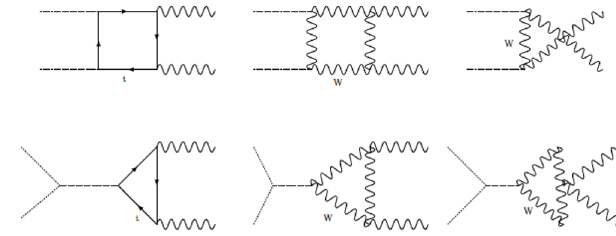
Figure 4 . The SM coupling of two Higgses to γγ